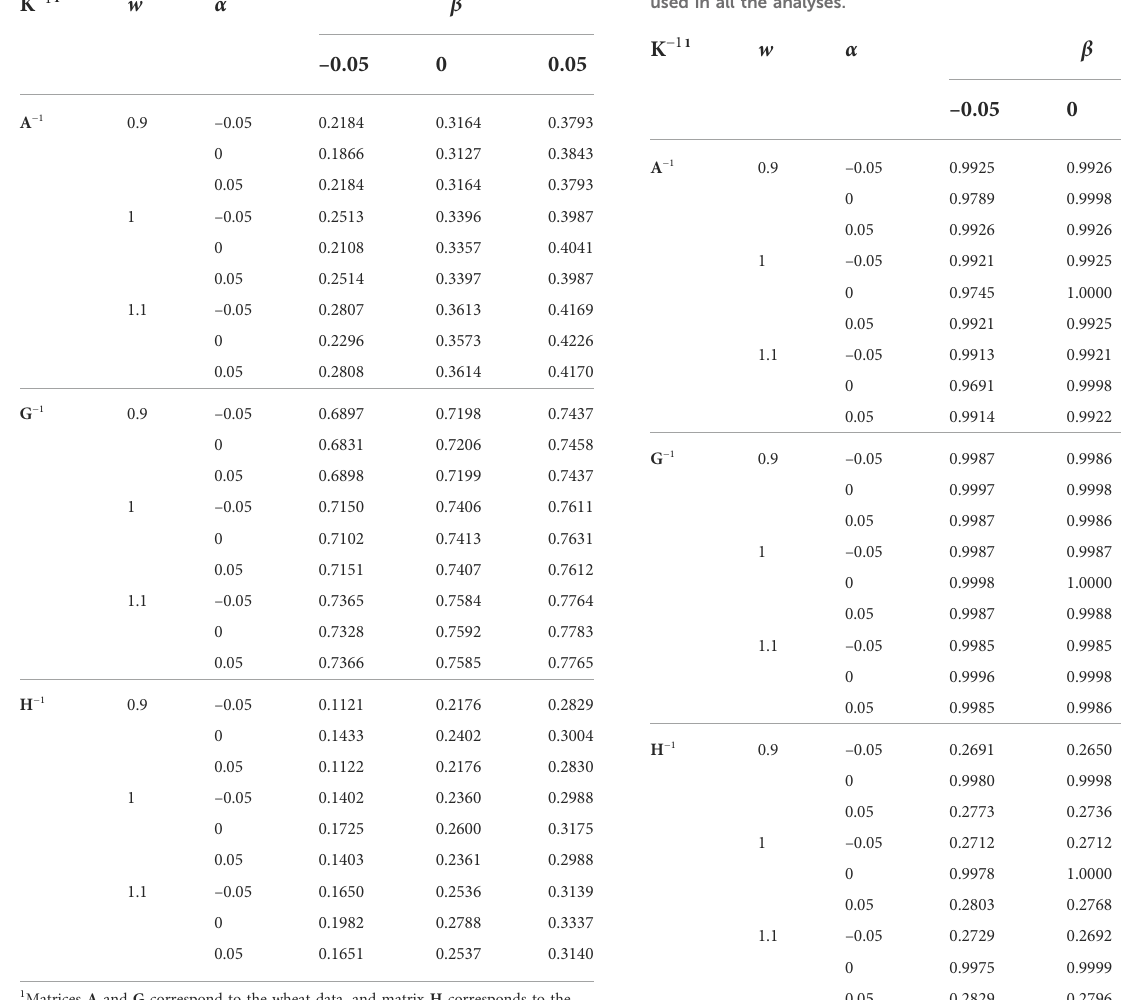
TABLE 4 The effect of w , α , and β ( w K − 1 + α 11 ′ + β I) on the heritability estimate. K − 1 1